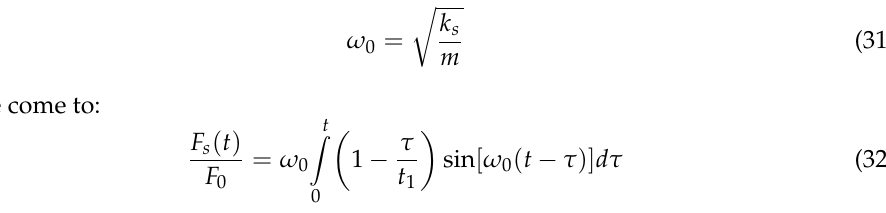
Figure 10. Estimated values of the force: 1: based on [8], 2: based on [4], 3: based on [7] (glass balls), 4: based on the extrapolation of the exponential part of pressure courses, 5: based on the maximum pressure values, 6: based on [10] (the dashed line is the black powder force). There is a little attention devoted in the literature to the reasons behind the scatter in the level of the primer reaction. The scatter of the mass of the priming mixture and the scatter of the mass of the priming mixture combustion products entering the chamber are too small to have caused the observed scatter of the pressure values. In [10], the authors guessed that the observed scatter of the primer output may be the result of the relationship between the mass of the priming mixture and the mass of the grains of the components. The mass of the priming mixture is small, while the grains of the ingredients are relatively large. Thus, the number of grains of a given component inside the primer may vary in some range. This means that the real priming mixture composition may differ from the nominal composition. Following this line of thinking, we can suppose that the position of